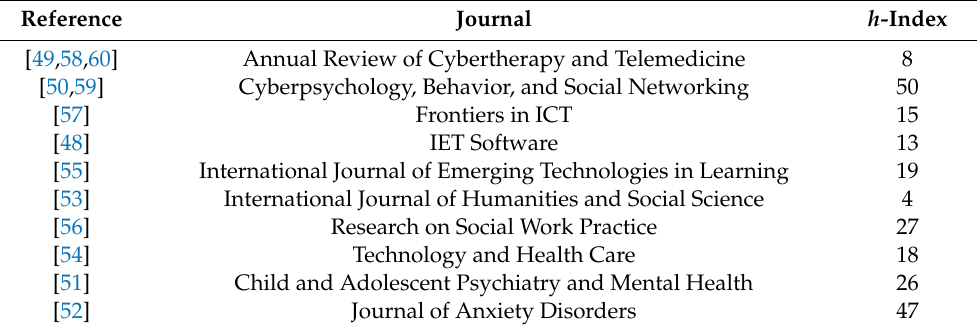
Table 4. Source title and h -index.